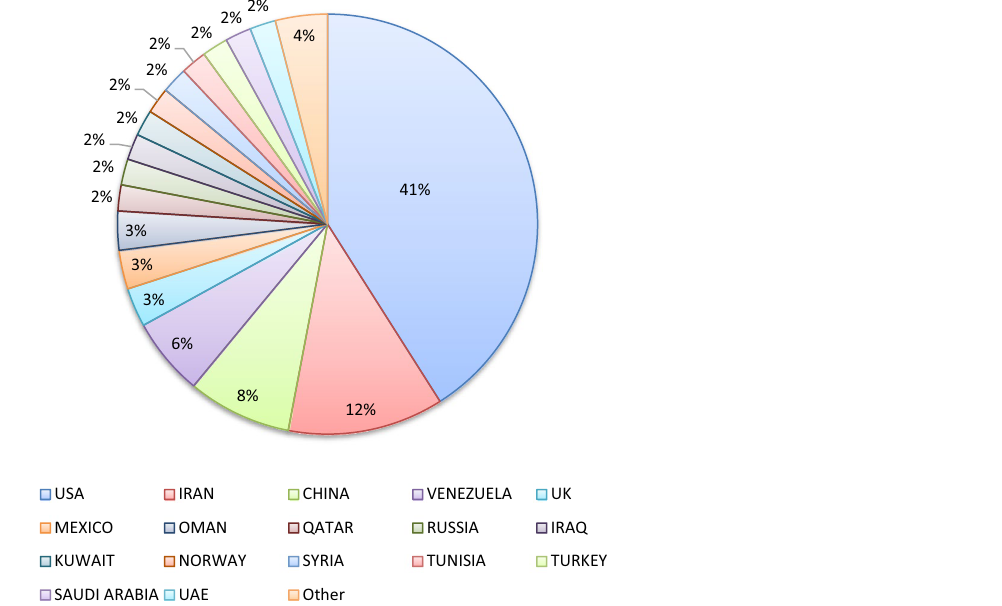
Figure 2. Total available data distribution by